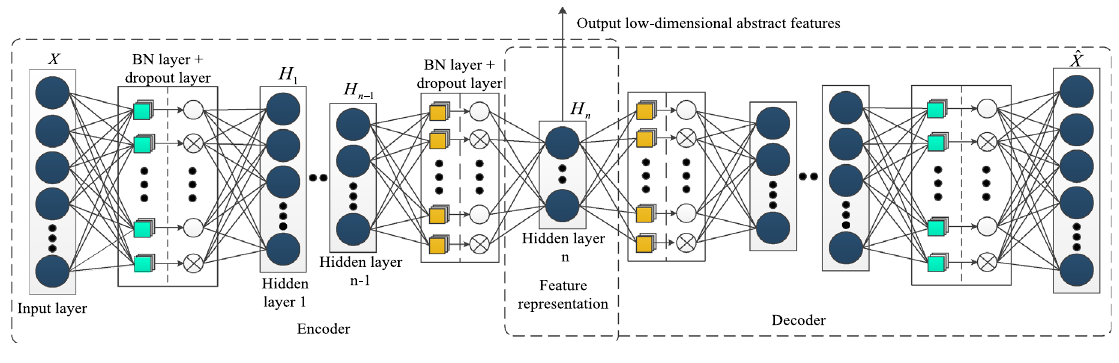
Figure 2. The structure of the